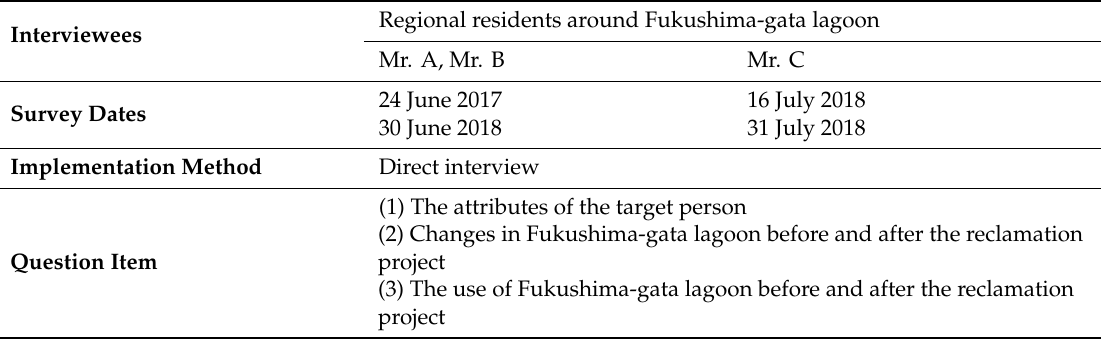
Table 1. Outline of the interview